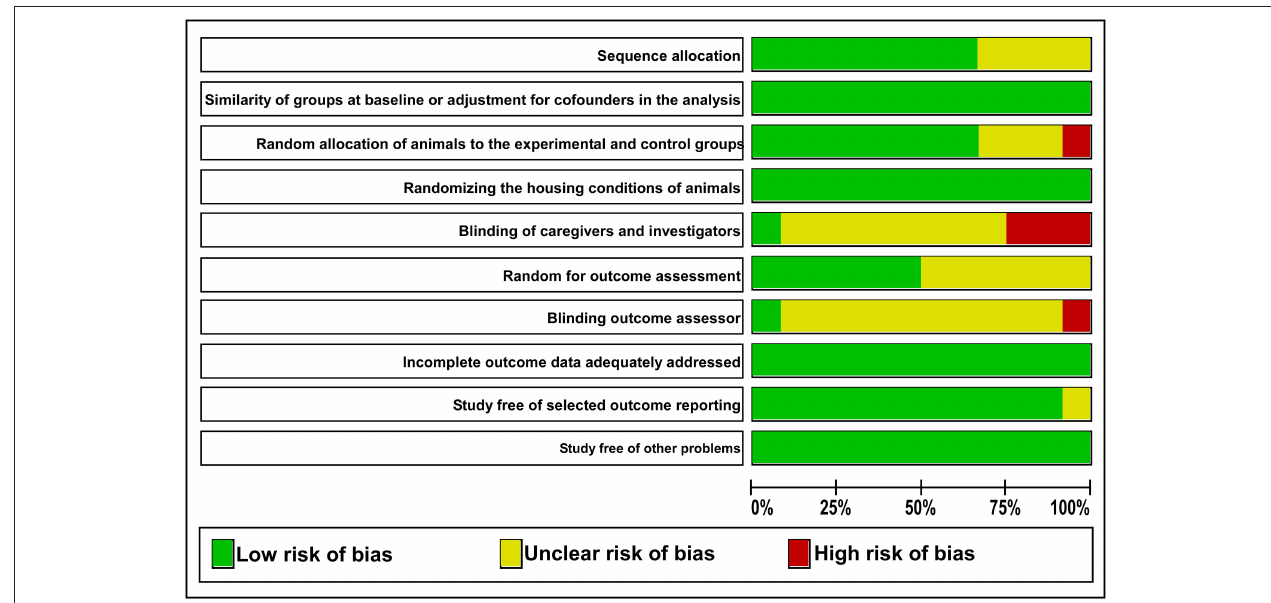
FIGURE 4 | The judgments of the reviewer of each risk of bias item are presented as percentages. The green color indicates a low risk of bias. The yellow color indicates an unclear risk of bias. The red color indicates a high risk of bias.